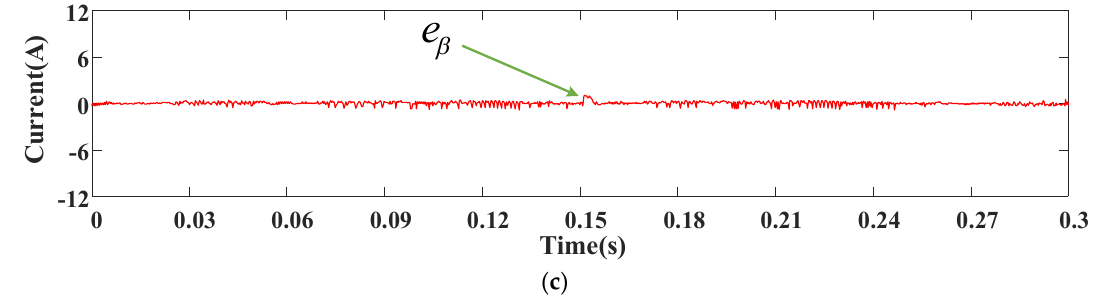
Figure 27. Experimental results of DVV-MFPCC following a sinusoidal current command with current reversed at 0.15 s under frequency 10 Hz (case 5): ( a ) current responses; ( b ) α -axis current error; ( c ) β -axis current error. Table 6. ACE , ACR , and ATHD of the four schemes obtained from Figures 8–11.